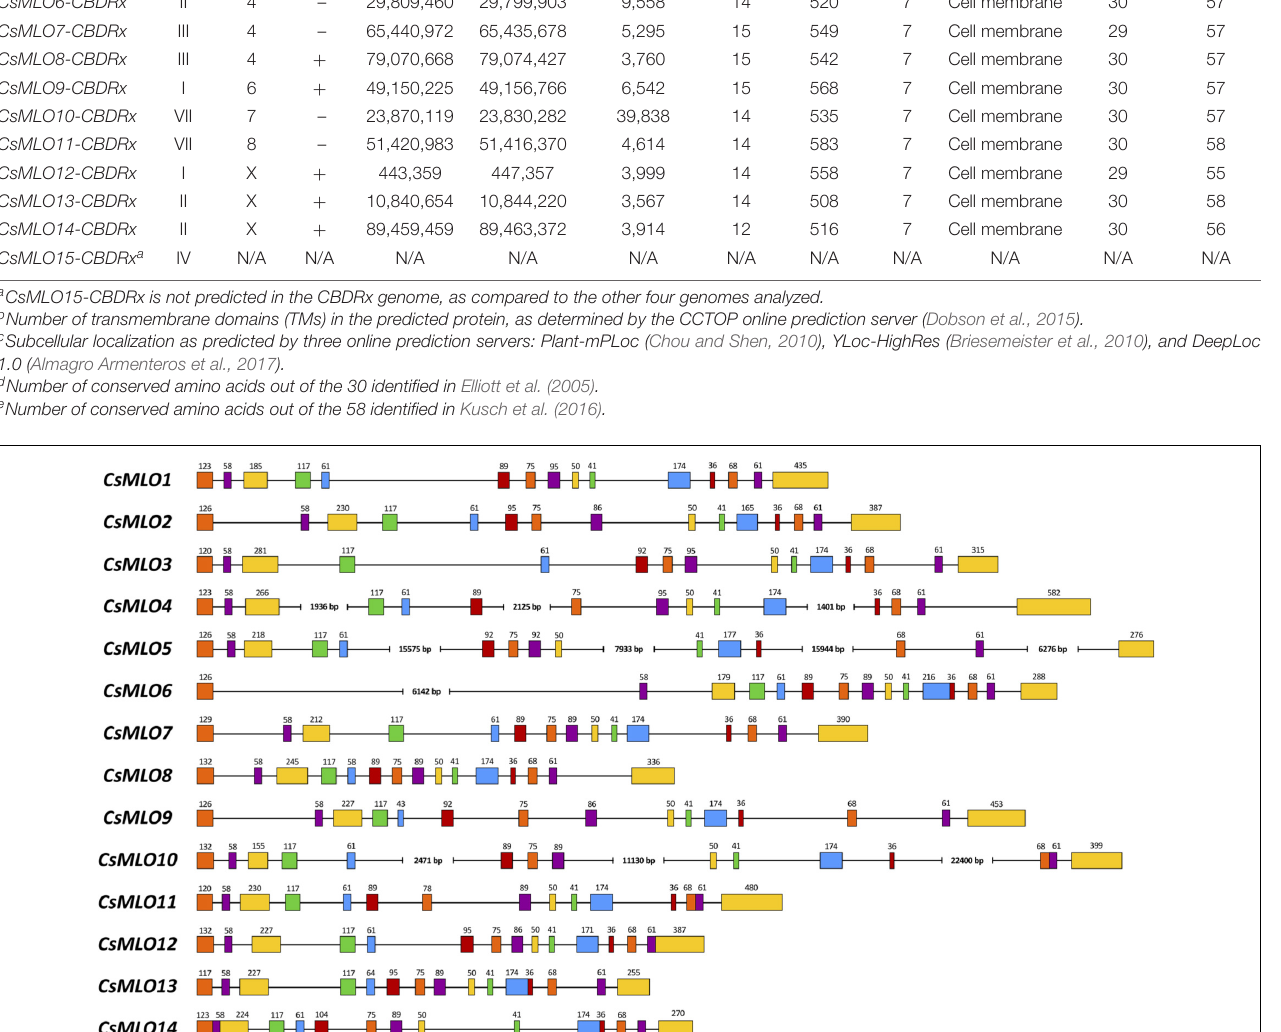
FIGURE 2 | Intron–exon organization of the 14 manually curated CsMLO genes identified in the CBDRx genome. Exons are shown as rectangles and introns as lines. The exon color code simply allows demonstrating exon conservation across all sequences. The numbers above exons indicate the exon’s length (bp). Note that the STOP codon (3 bp) is included in the last exon’s length. Sequences exhibiting one or several large introns are severed where necessary (i.e., CsMLO4 , CsMLO5 , CsMLO6 , and CsMLO10 ) and are therefore not drawn to